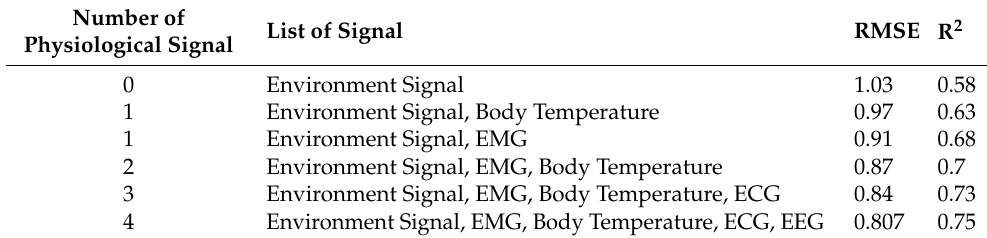
Table 7. Sequence of ranking physiological